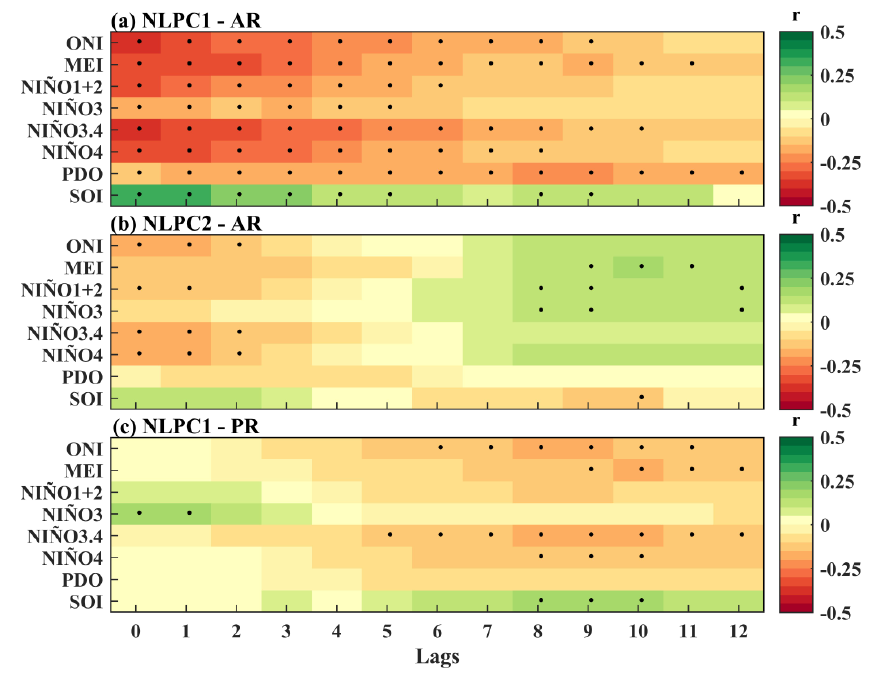
Figure 7. Cross-correlograms between climate-oceanographic indices and: ( a ) NLPC1-AR, ( b) NLPC2-AR, and ( c ) NLPC1-PR. The statistically significant correlations are shown with a dot (significance level of 0.05 is ± 0.128).